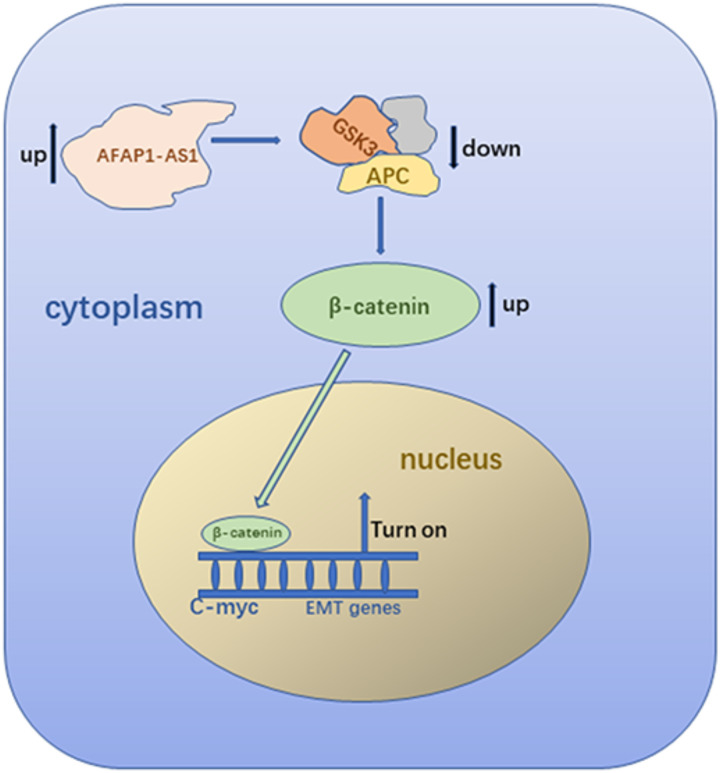
Diagrammatic sketch of molecular mechanism.